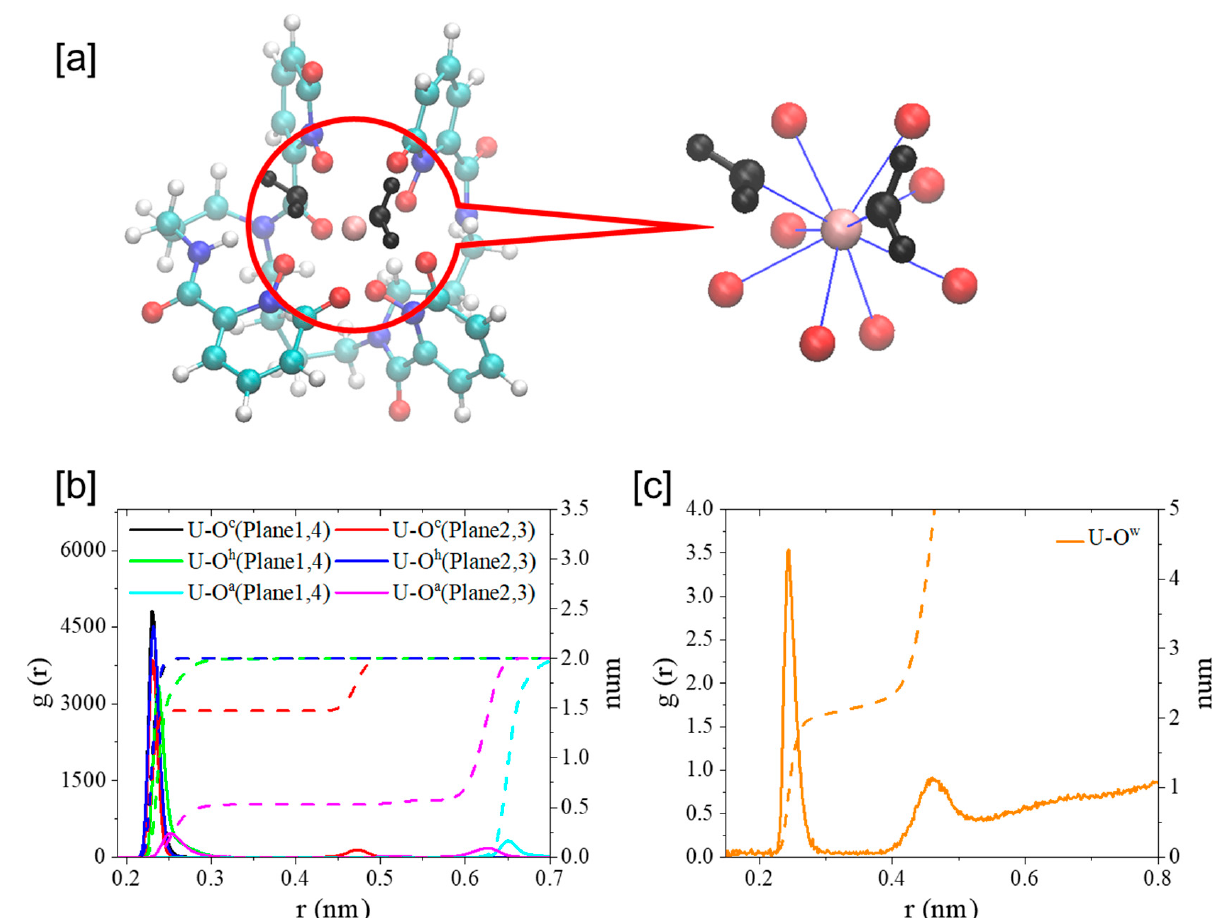
Figure 8. The typical structure of U 4+ coordinated with t -HOPO 4 − and two water molecules ( a ); radial distribution functions (RDF, solid lines) of O h , O c ( b ) and O w ( c ) around metal ion (U 4+ ) and their integrals (dash lines) calculated from the 100 ns MD simulations. Color scheme: N atoms in blue, O atoms in red, water molecules in black, C atoms in cyan and H atoms in white.